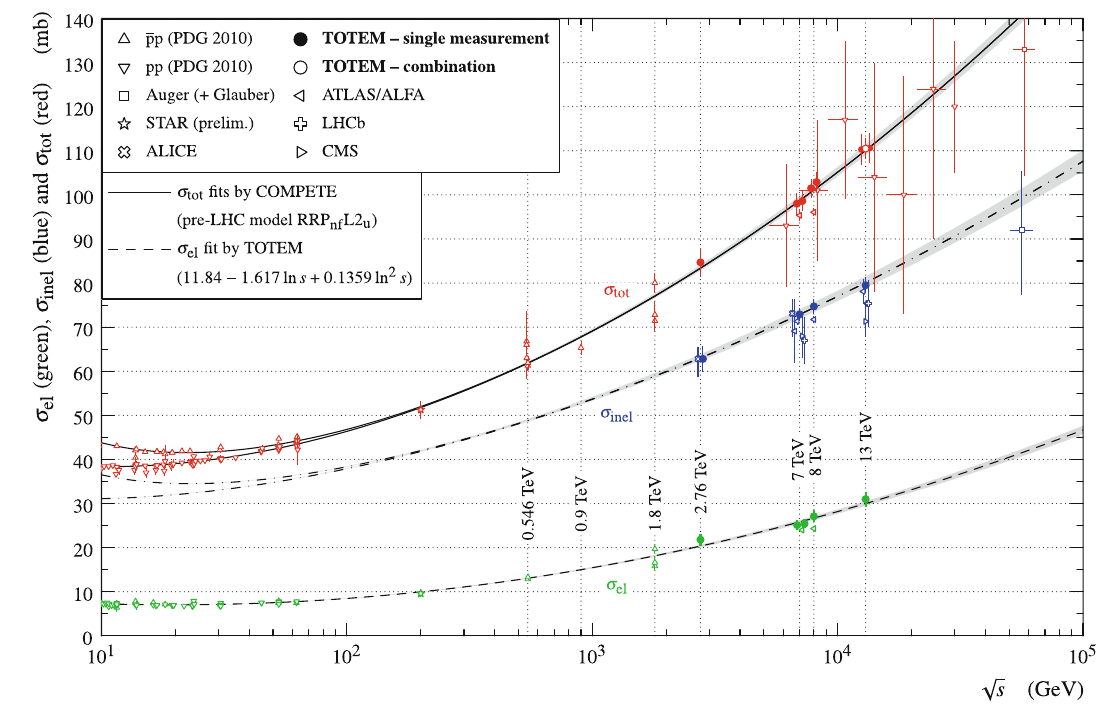
Fig. 19 Total (red), inelastic (blue) and elastic (green) cross-section as √ s . The data are taken from Ref. [6] (and refer- a function of energy, √ s = 13TeV, three total cross-section ences therein) and Table 5. At